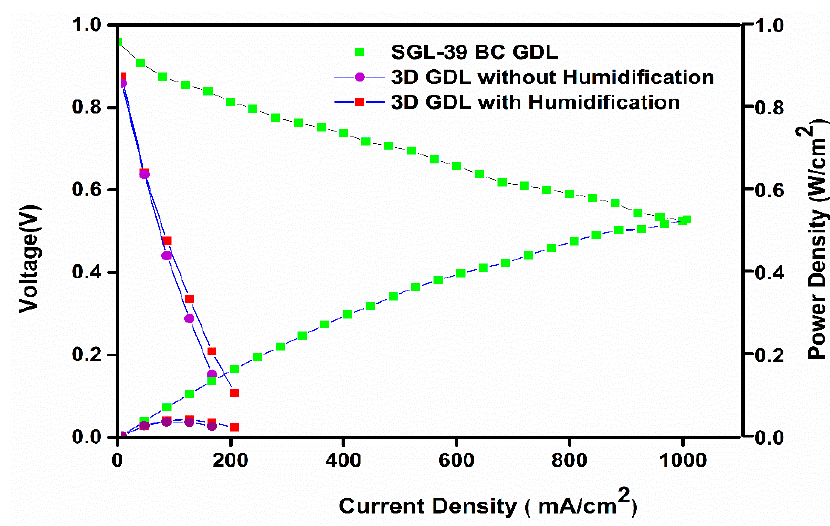
Figure 4. Polarization plots for the 3D-printed GDL [80% PA + 20% Ti] used membrane and electrode assembly (MEA) and normal MEA tested with humidified H 2 /O 2 at 75 °C and 15 psi pressure.